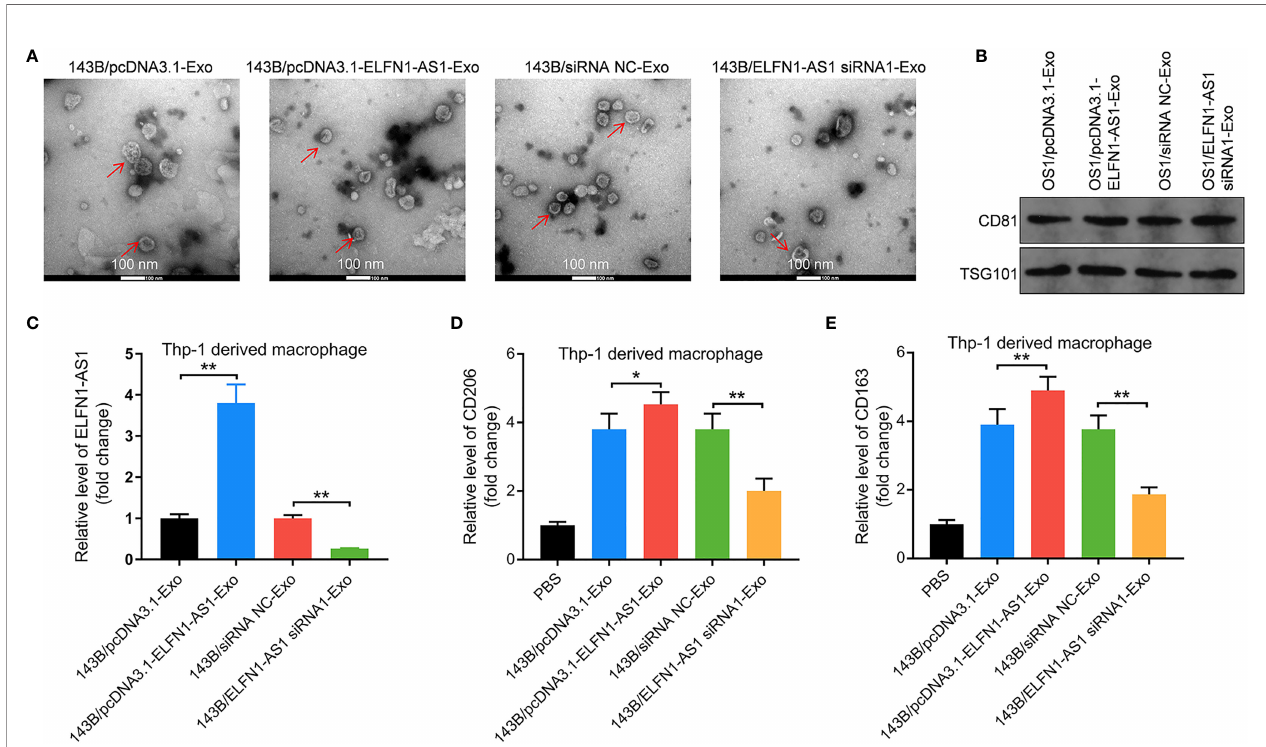
FIGURE 4 | Exosomes with upregulated ELFN1-AS1 promoted macrophages M2 polarization. (A) Exosomes were isolated from the CM of 143B cells transfected with pcDNA3.1 ELFN1-AS1 (143B/pcDNA3.1-ELFN1-AS1-Exo) or ELFN1-AS1 siRNA1 (143B/ELFN1-AS1 siRNA1-Exo). The size of exosomes was assessed by NTA assay. The morphology of exosomes was observed by TEM at 100 keV. Red arrow, exosomes. (B) The expression of exosome surface markers CD81 and TSG101 were detected with western blot assay (n = 3). (C) RT-qPCR analysis of ELFN1-AS1 level in macrophages (n = 3). (D, E) RT-qPCR analysis of CD206 and CD163 level in macrophages (n = 3). The signi fi cance between groups was analyzed by one-way ANOVA. *P < 0.05; **P <